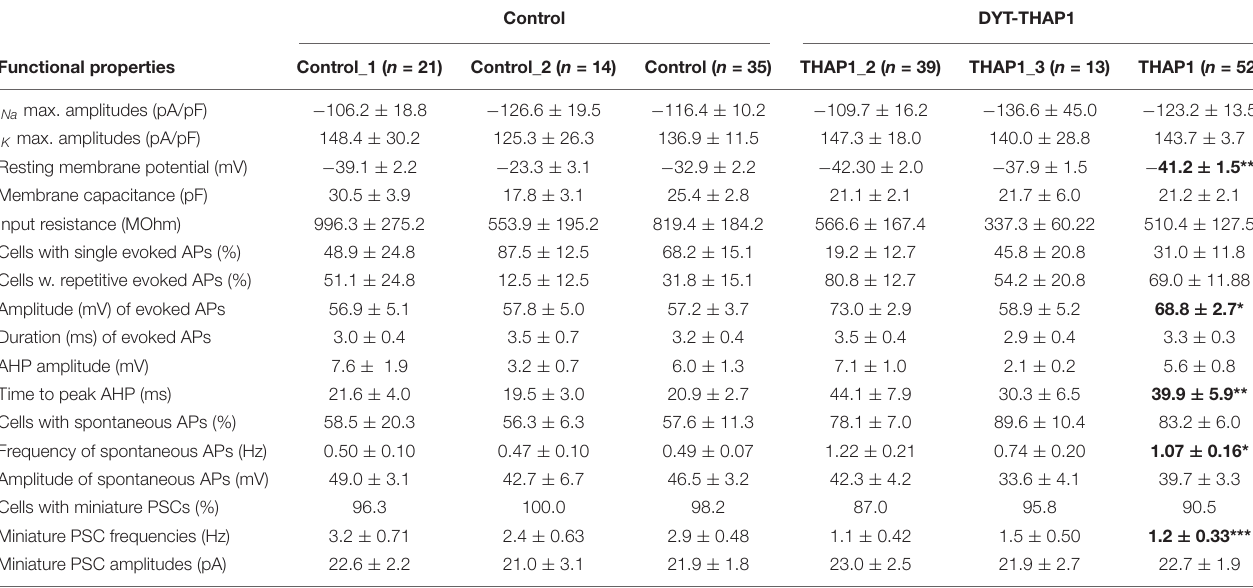
TABLE 2 | Electrophysiological properties recorded by whole-cell patch-clamp of iPSC-derived MSNs from two DYT-THAP1 mutation carriers (THAP1_2 and THAP1_3) and two healthy controls. Control